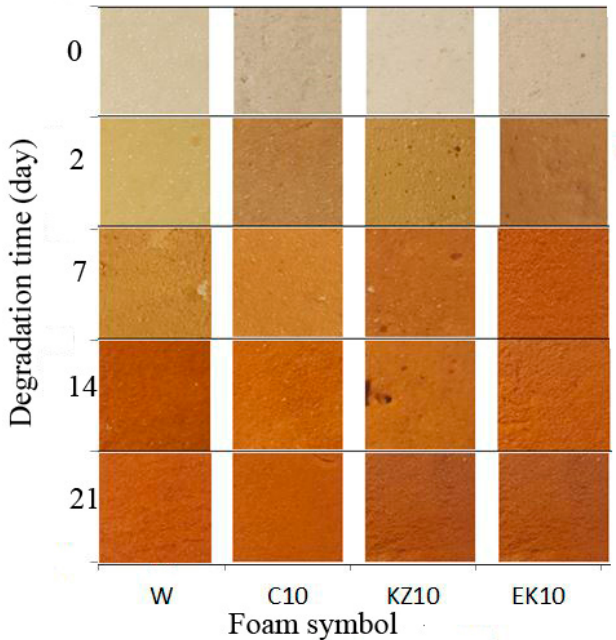
Figure 1. Change in the color of foams after the drying process in the air dryer (2-day) and